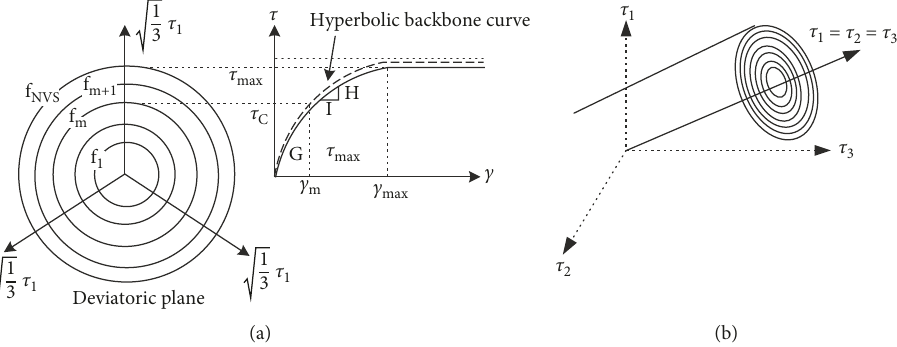
Figure 4: Yield surfaces of multiyield surface J 2 plasticity model: (a) octahedral shear stress-strain and (b) von Mises multiyield surfaces